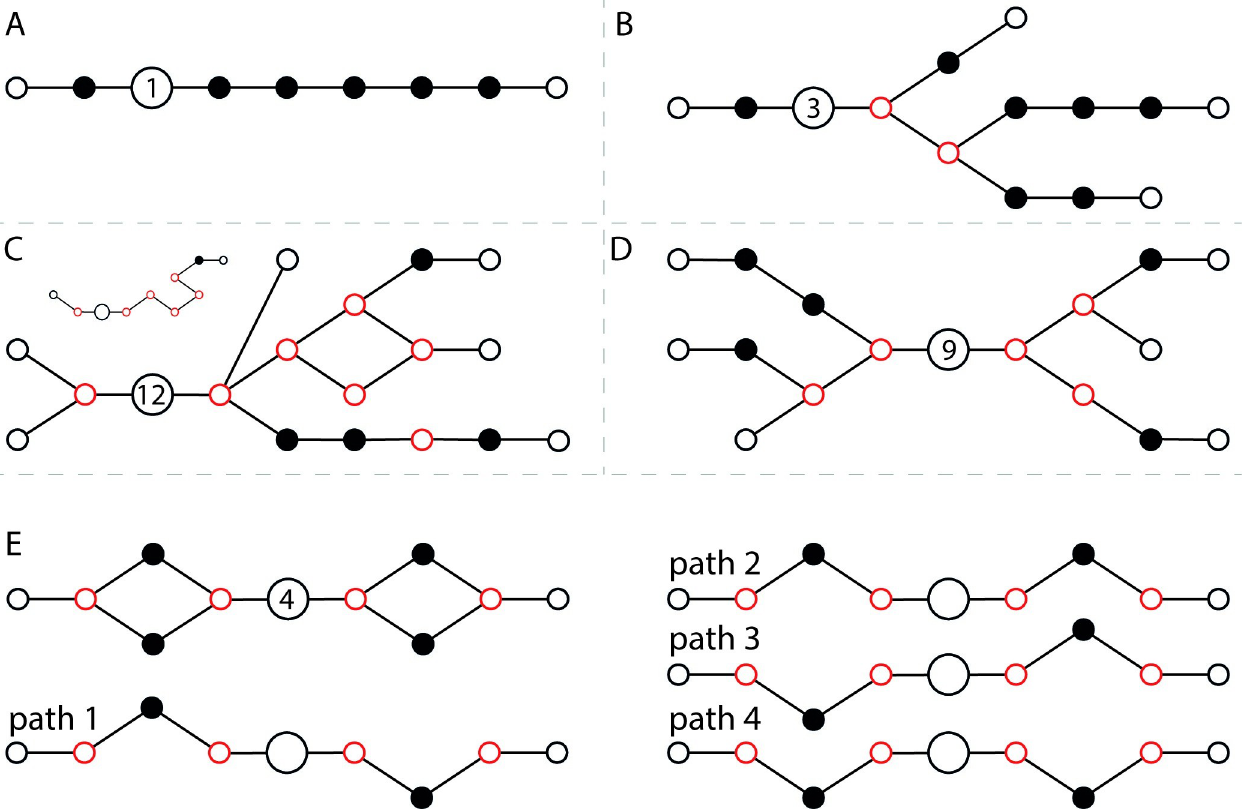
Fig 3. Three levels of graph classification implemented within CStone. Panels A to C display examples of graphs identified with classification levels 1 to 3 in order. The largest node indicates the cornerstone node whilst the number inside this indicates the number of possible paths passing through. In panel C one path (inset), of the possible 12, is shown. In the absence of read coverage information, as in this example, the path is most likely chimeric as it turns away from the nearest exit node and follows a more winding route. However, within real graphs coverage information could provide a justification for such a route. Panels D and (e) highlight two additional examples of graphs within classification level (iii). For the latter the four paths traversing the graph containing two cycles in sequence are shown, only two of which are required to reconstruct the original graph (paths 1 and 3) or (paths 2 and 4), leaving two possible chimeric